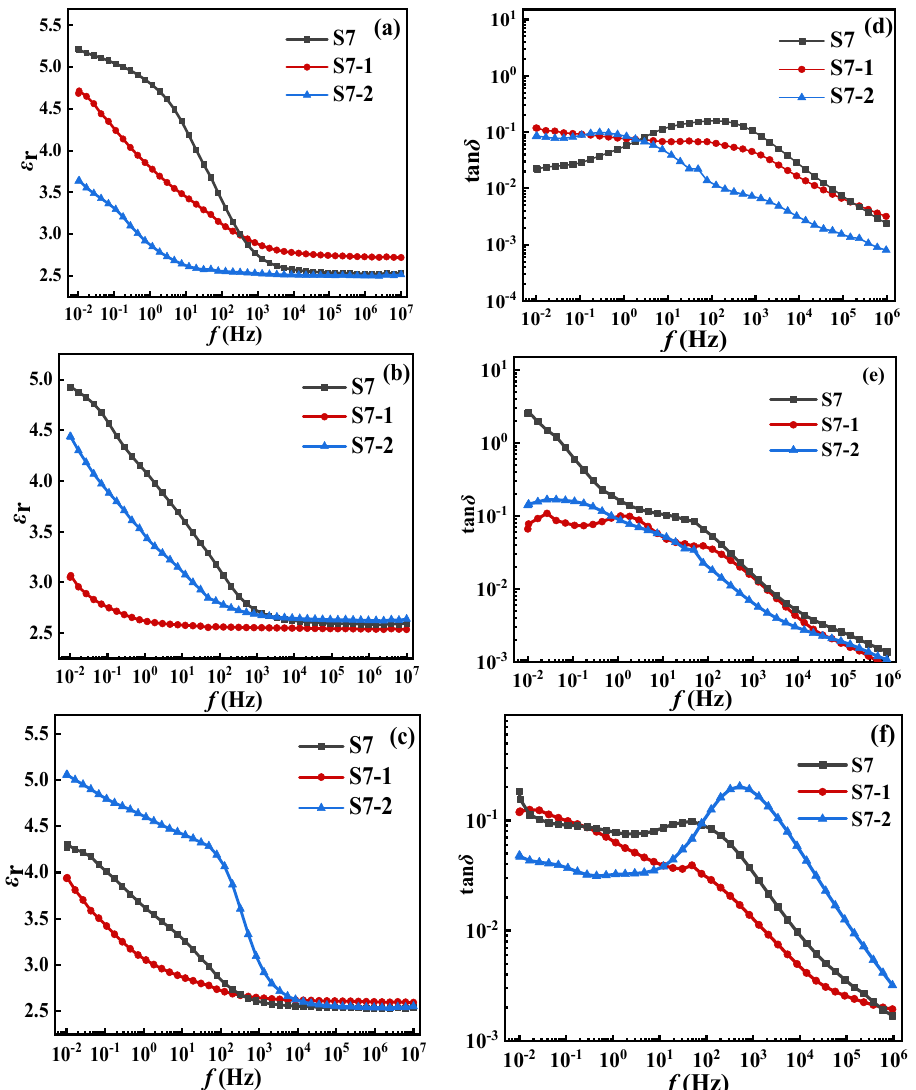
Figure 7. The ε r and tan δ of each insulating layer. ( a ) The ε r of inner insulating layer; ( b ) The ε r of middle insulating layer; ( c ) The ε r of outer insulating layer; ( d )The tan δ of inner insulating layer; ( e )The tan δ of inner insulating layer; and ( f )The tan δ of inner insulating layer.